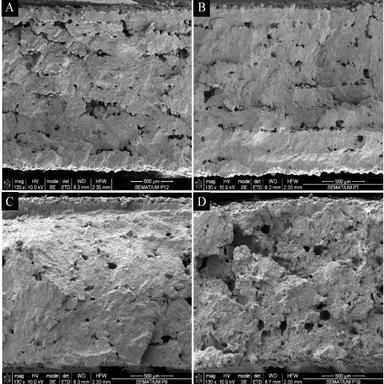
SEM images showing the cross-section of SLS test specimens produced with EDV of (A) 0.158 (B) 0.198 (C) 0.278 (D) 0.358 J/mm3 .